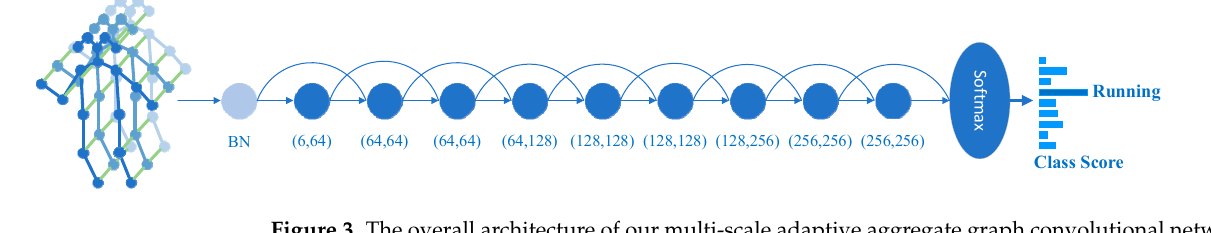
Figure 3. The overall architecture of our multi-scale adaptive aggregate graph convolutional network. It consists of 9 basic modules (as shown in Figure 1), which are indicated by dark-colored circles, and the numbers below these circles indicate their input and output channels, respectively. Each module contains the residual links in the figure. Light-colored BN circle represents batch normalization layer for data normalization, and the standard Softmax classifier is used for action category.